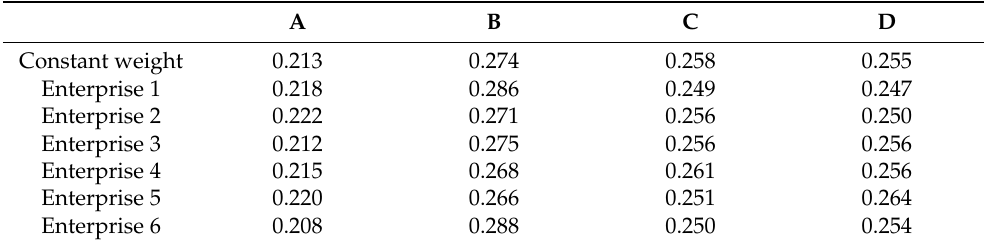
Table 8. Variable weights of the primary indicators for the social effect evaluation of six enterprises’ carbon